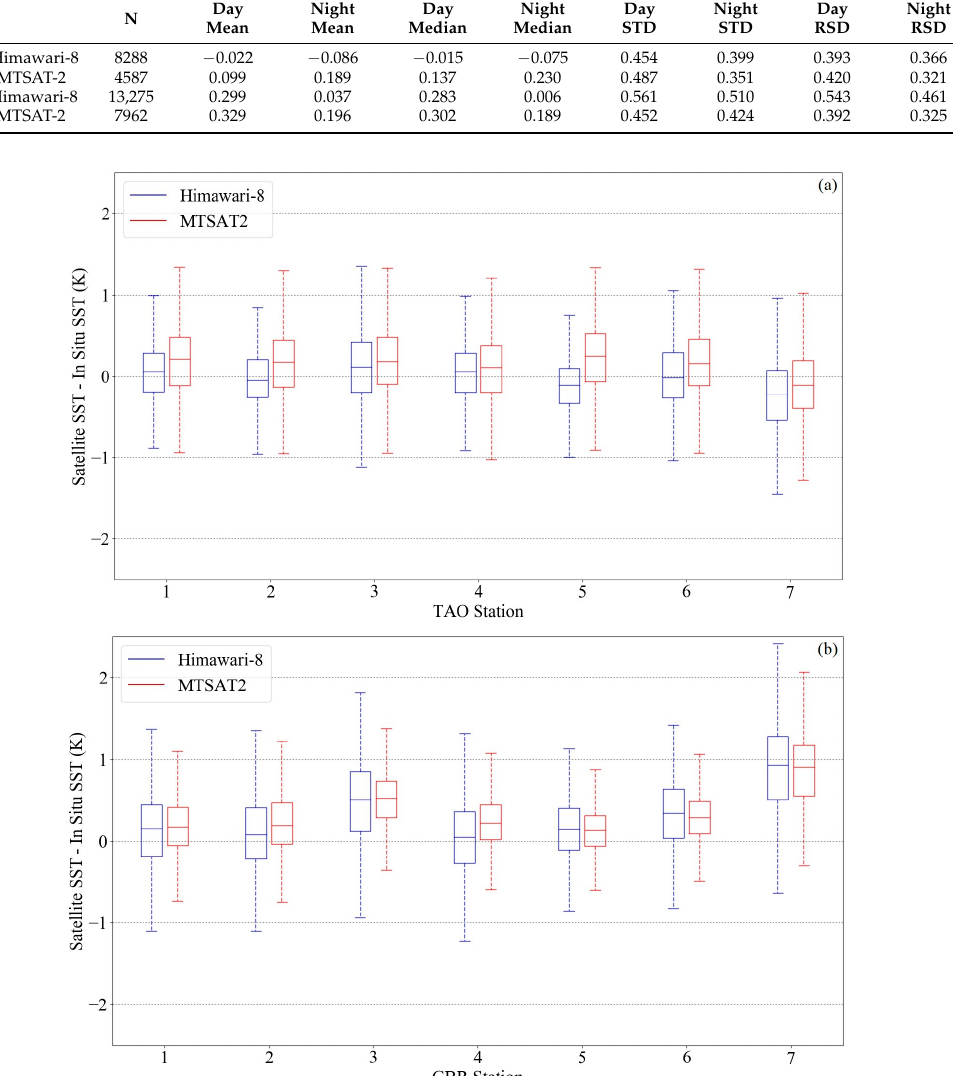
Figure 2. Box plots for the temperature difference between the satellite-derived SST and subsurface temperature at each TAO mooring ( a ) and GBR station ( b ). Blue boxes and whiskers represent the temperature differences for the Himawari-8 SSTs. Red represents the temperature differences for the MTSAT-2 SSTs. Outliers are not plotted.